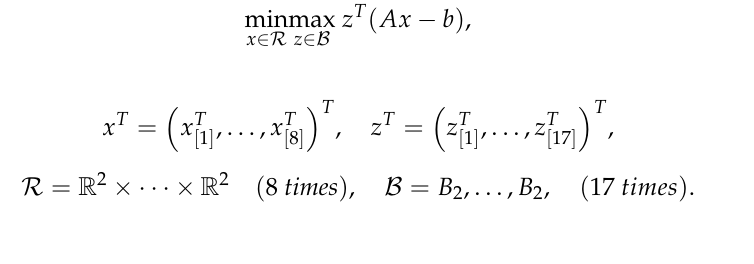
Algorithm 3.1 Cholamjiak et al alg Dong et al alg